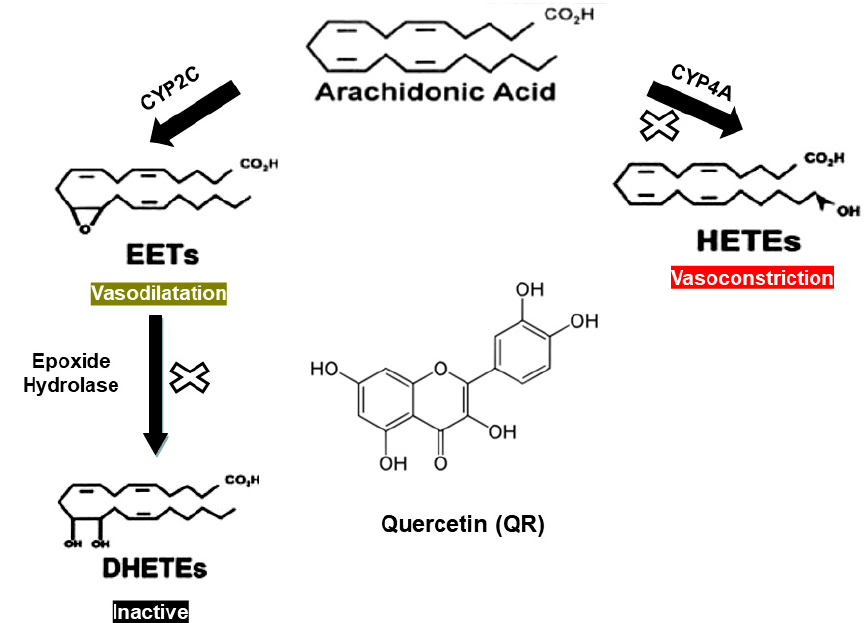
Figure 1. Pathways for cytochrome P450 (CYP)-mediated metabolism of arachidonic acid in the kidney. The present study examines pathways marked with the sign “x” as a potential mechanism for the blood pressure ‐ lowering effect of QR.